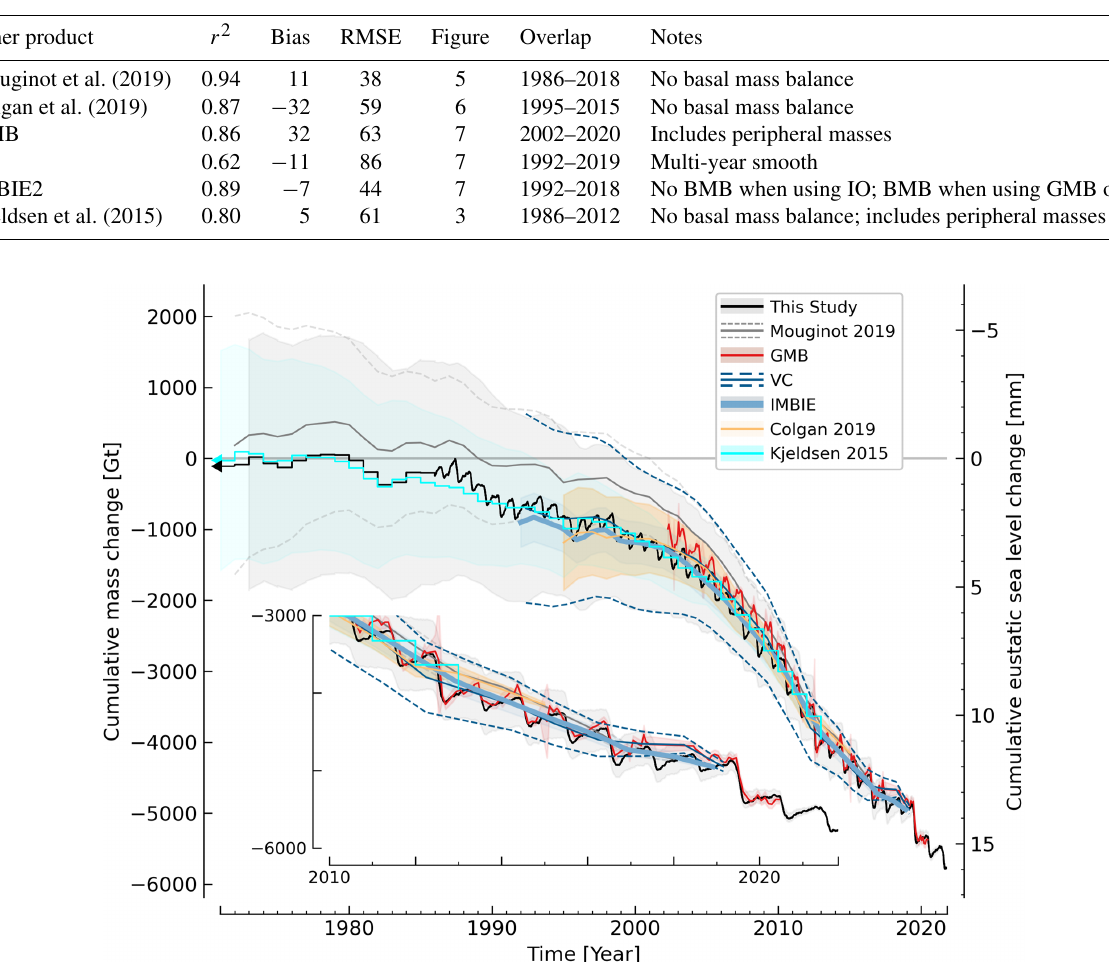
Figure 4. Comparison between This Study and other mass balance time series. Note that various products do or do not include basal mass balance or peripheral ice masses (see Table 2). This Study annual-resolution data prior to 1986 are the Kjeldsen et al. (2015) data adjusted as described in Sect. 5.4. Sea level rise calculated as − Gt / 361 . 8. Inset highlights changes since 2010. Data product version 74 from 25 October 2021 used to generate this